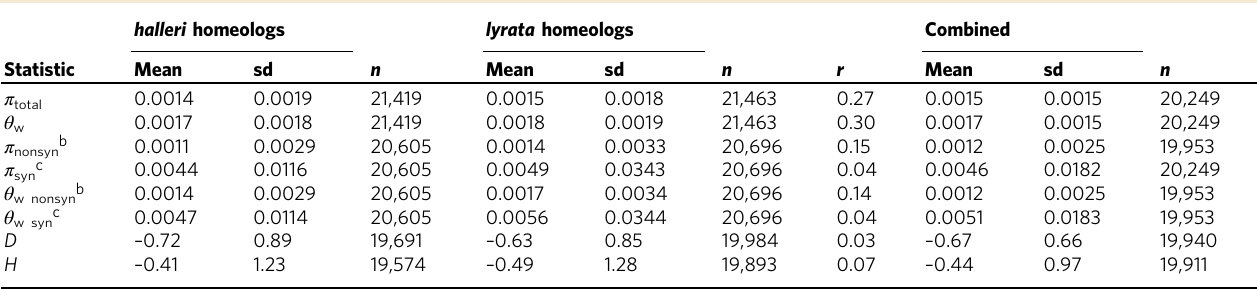
Table 2 Diversity statistics for coding sequences of A. kamchatica homeologs a